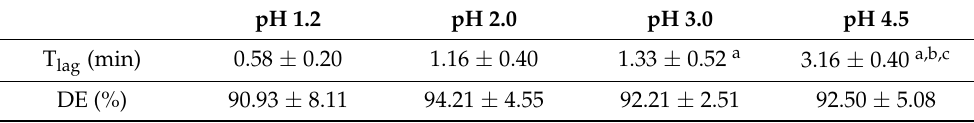
Figure 2. Metronidazole’s in vitro release profile versus time for distinct pH mediums. ( n = 6). Table 1. Lag time (T lag ) and dissolution efficiency (DE) for coated magnetic tablets in different pH dissolution mediums ( n = 6).